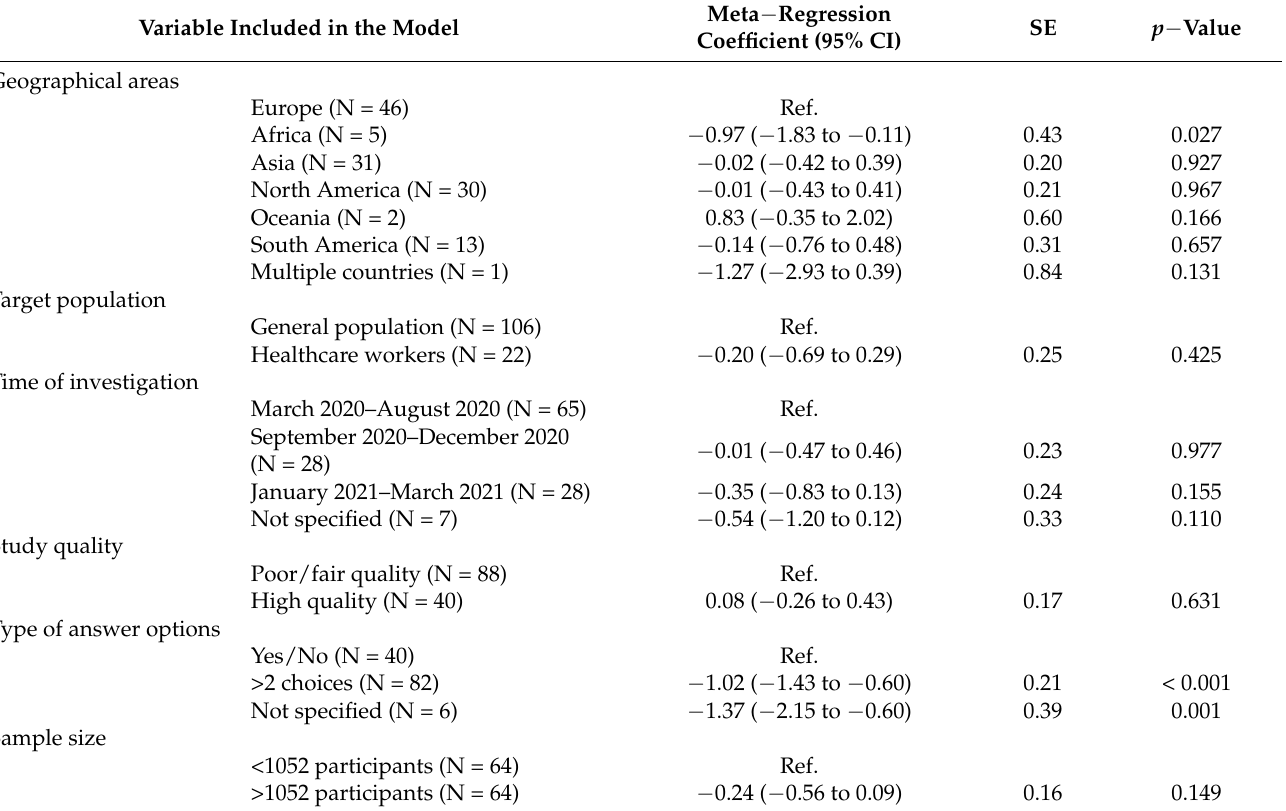
Table 3. Multivariable meta-regression model predicting the pooled estimate of the prevalence of COVID-19 vaccination acceptance at the global